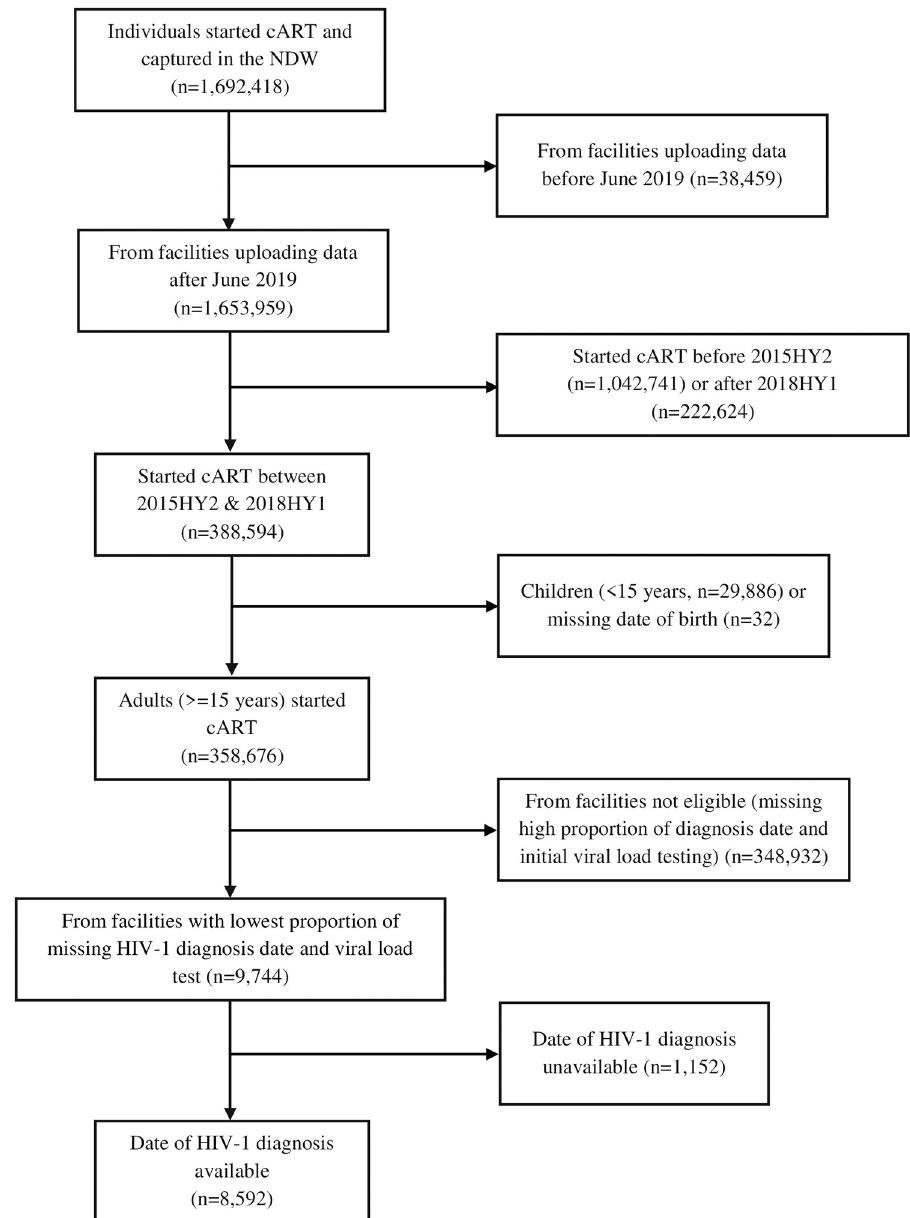
Fig 1. Flow chart showing distribution of HIV infected individuals captured in the national data warehouse (NDW) and selection of eligible individuals carried forward to the